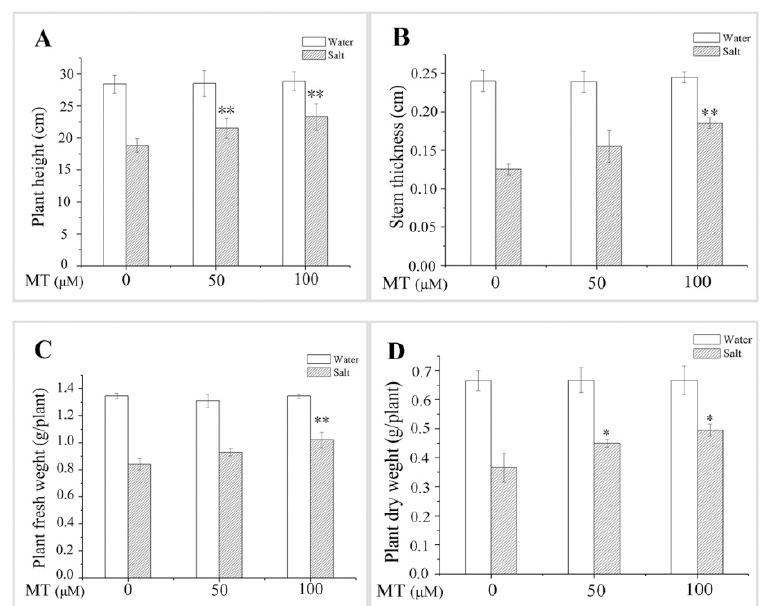
Figure 1. Effect of pretreating with different concentrations of melatonin (MT) on growth of leaves of naked oat seedlings under salt stress. ( A ) Plant height; ( B ) stem thickness; ( C ) plant fresh weight; ( D ) plant dry weight. Values are mean ± standard deviation ( n = 3). 0, 50, and 100 represent MT concentration ( µ M) in Figure 1. Asterisks; * and ** indicate significant difference ( p < 0.05 and p < 0.01, respectively) compared with mock coating (0 µ M). Measurement was carried out after six days of the salt plus MT pretreatmemt.